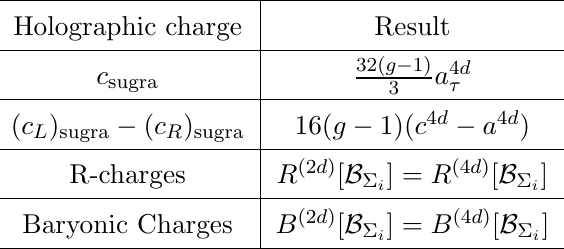
Table 3 . Holographic charges for the universal twist with elliptic threefold T (cid:28) central charge of the dual to the solutions in section